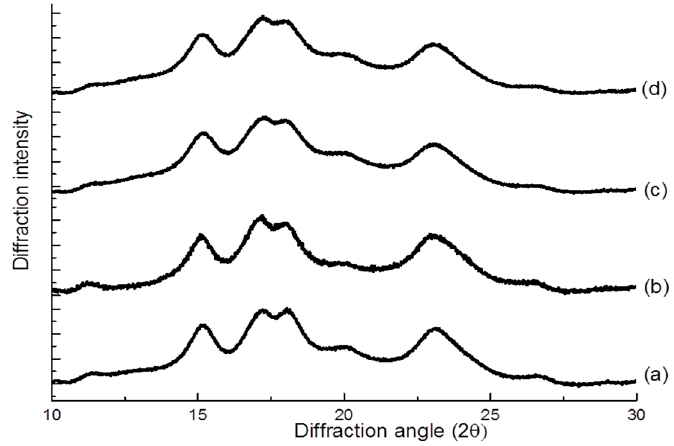
Figure 2. X-ray diffraction pattern for ( a ) native, ( b ) succinylated, ( c ) annealed, and ( d ) dual modified corn starch. corn